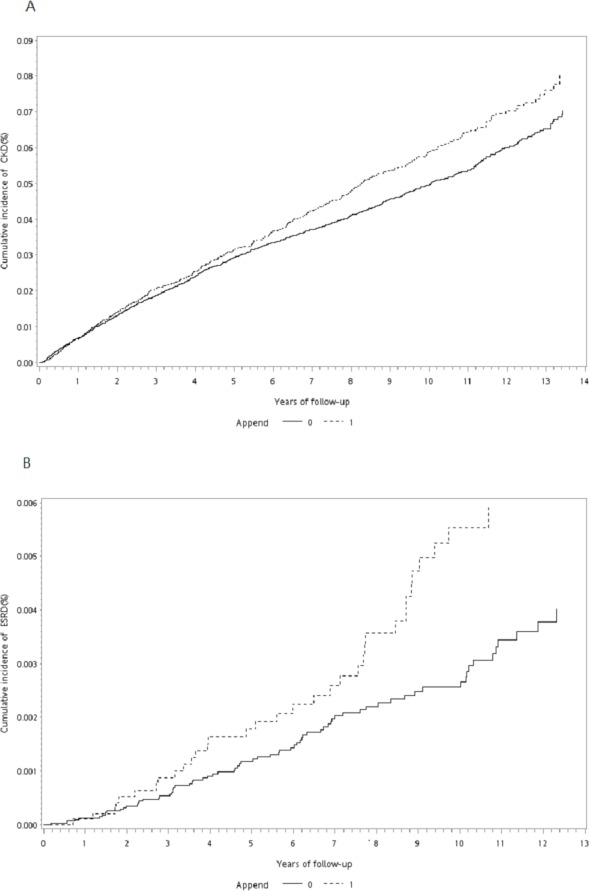
Cumulative incidence curve of CKD and ESRD.(A) Cumulative incidence curve of CKD for patients after appendectomy compared with control cohort. (B) Cumulative incidence curves of ESRD for patients after appendectomy compared with control cohort.